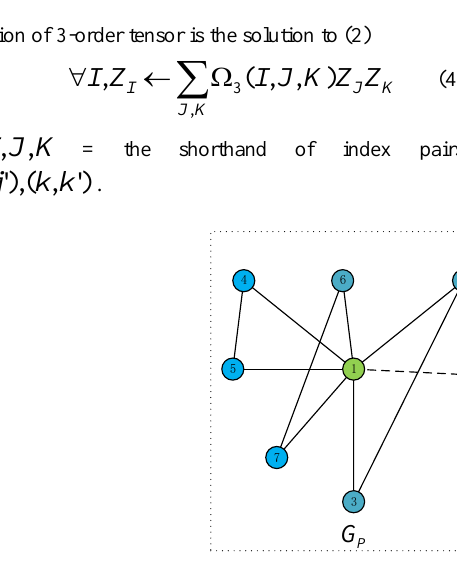
Figure 3 sketch of power iteration in the perspective of nodes, the pink circles are outliers